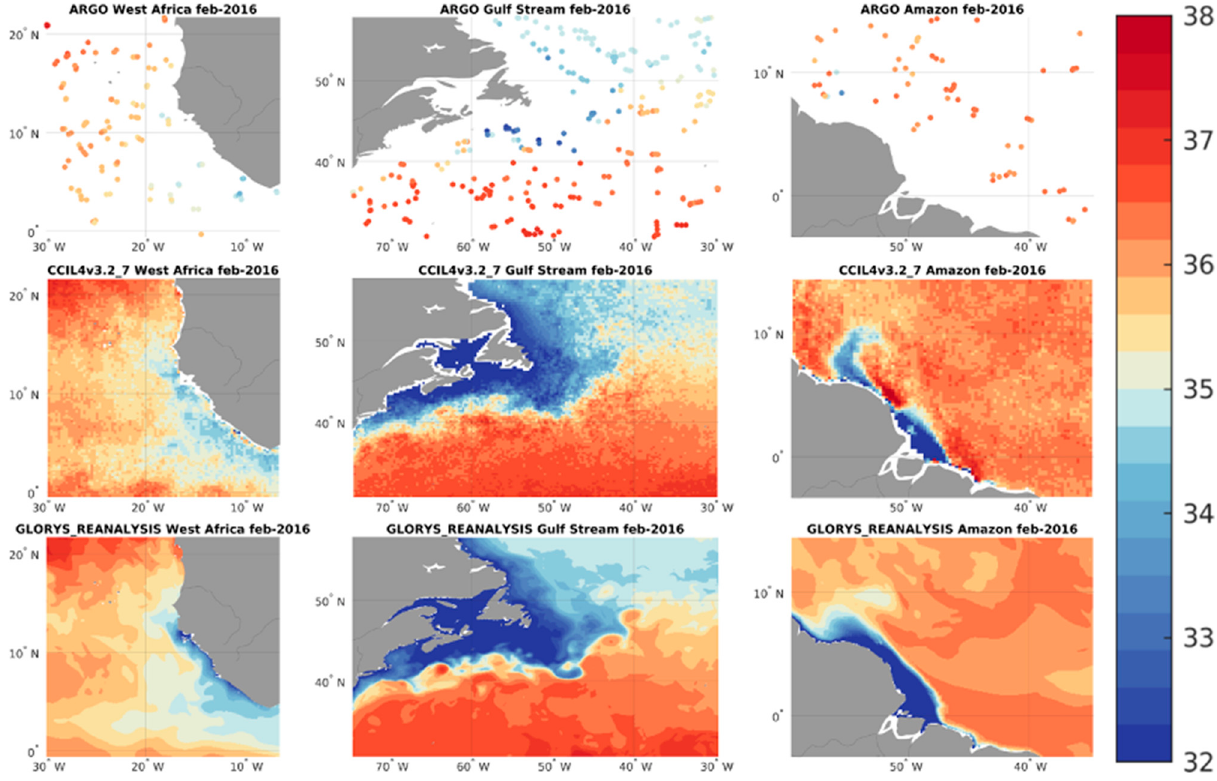
Figure 1. Examples of SSS measured in three regions, in February 2016. Top : ARGO floats, Middle : CCI, Bottom : GLORYS Reanalysis; Column 1: West African coast; Column 2: Gulf Stream; and Column 3: Amazon plume.